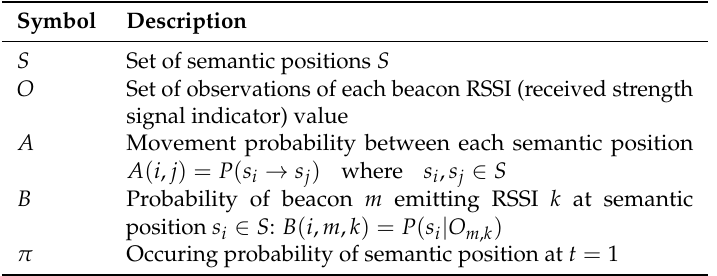
Table 1. HMM of semantic trajectory extraction.